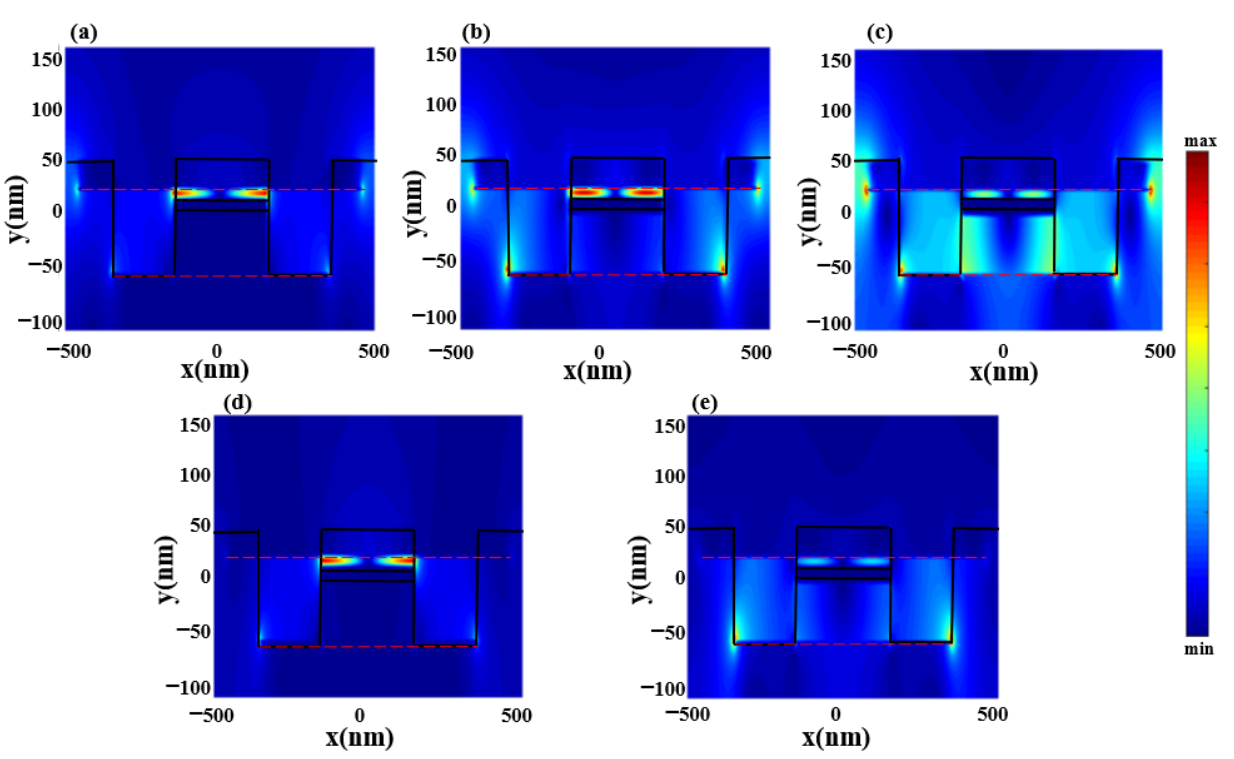
Figure 4. Distribution of the electric field at frequencies of ( a ) 3.08 THz, ( b ) 5.46 THz, ( c ) 6.69 THz, ( d ) 3.59 THz, and ( e ) 5.75 THz.